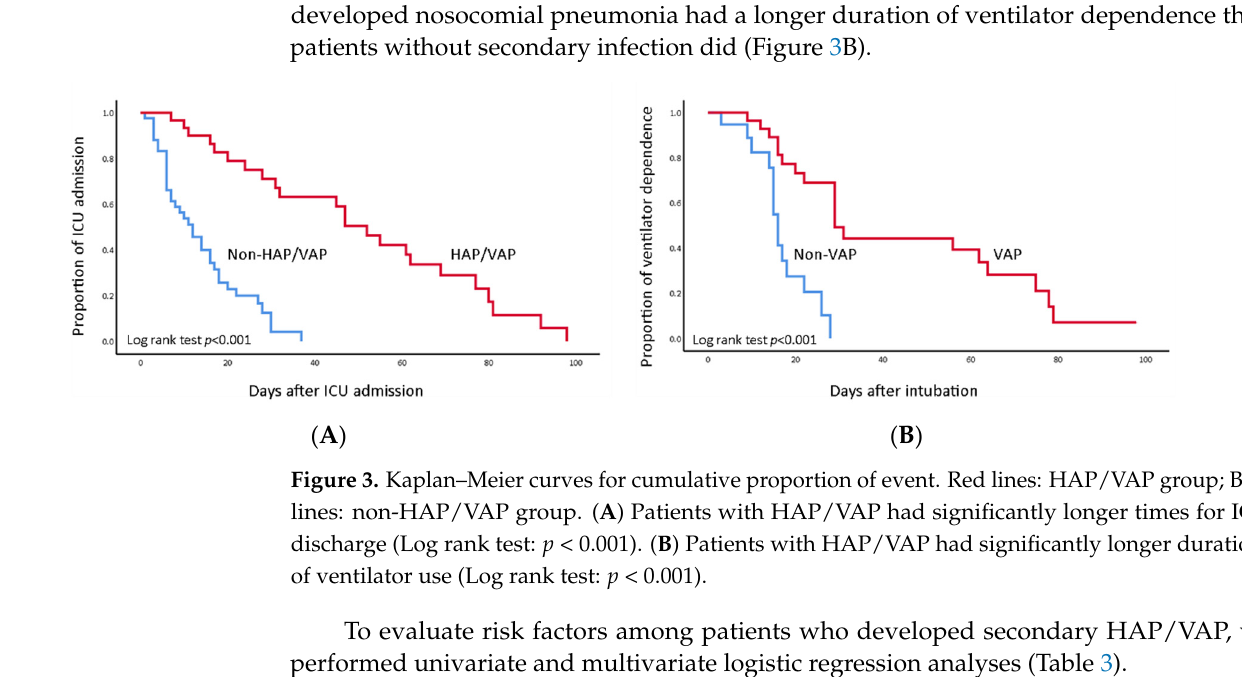
Table 3. Association of HAP/VAP by univariate and multivariate logistic regression analyses. Univariate a Multivariate a